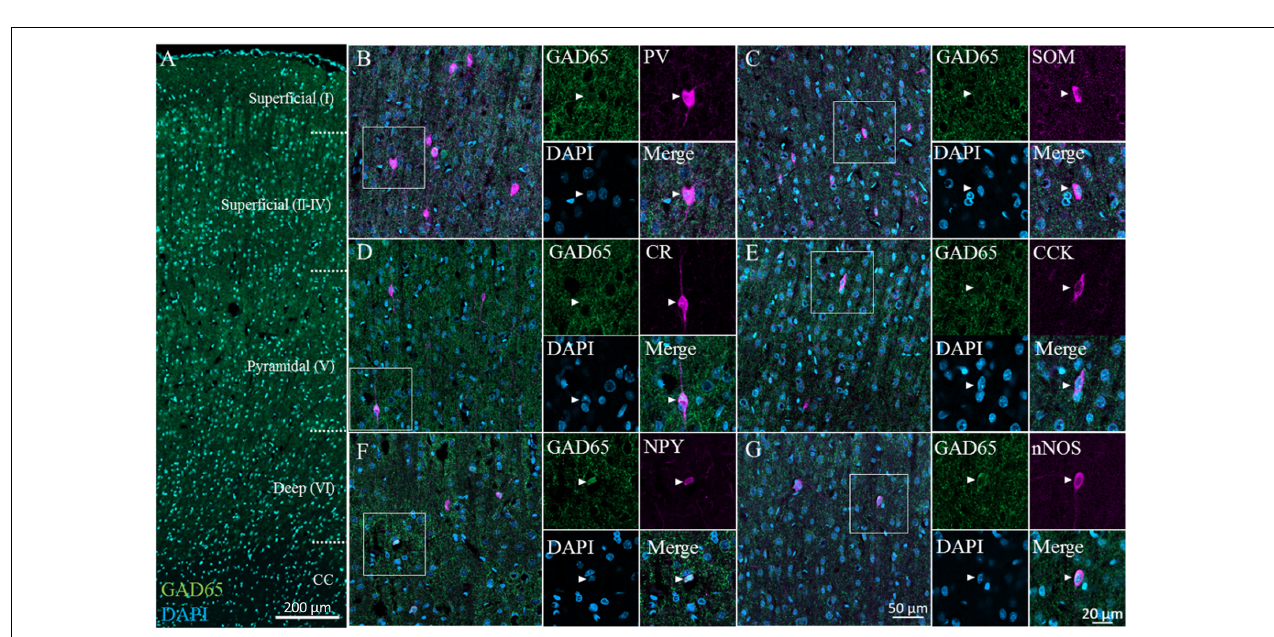
FIGURE 1 | Measuring GAD65 staining intensity in somata in the cerebral cortex and hippocampus. Schematic drawing of a coronal section of an adult rat brain showing the cerebral cortex ( A: upper inset B ) and hippocampus ( A: lower inset C ). The cerebral cortex and hippocampus were each divided into three layers. Solid lines and dashed lines indicate the region of interest and the boundaries between layers, respectively, in the cerebral cortex (B) and hippocampus (C) . The area of GAD65 expression in the soma was surrounded by synaptic buttons in the 2D ( D: arrowhead) and 3D images ( E: ortho-image from the x , y , and z planes). The level of GAD65 expression was calculated by subtracting the background (BG) intensity from the average intensity of four squares (F) . CC, corpus callosum.